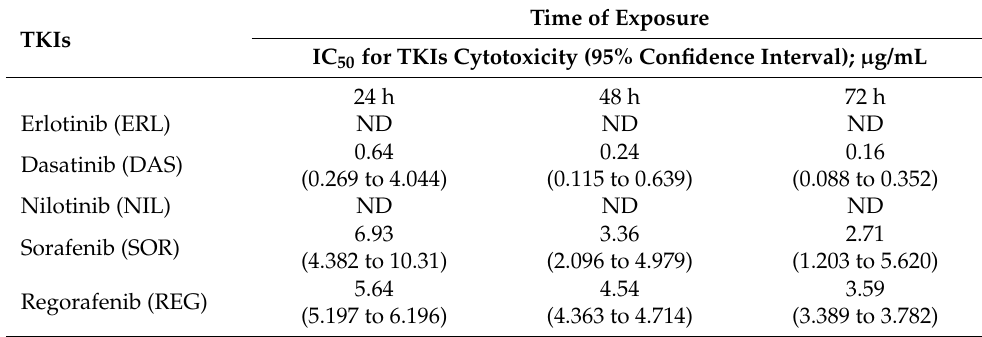
Table 2. IC 50 values of TKIs in zebrafish liver cells (ZFL) after 24, 48, and 72 h of exposure. Time of Exposure TKIs IC 50 for TKIs Cytotoxicity (95% Confidence Interval); µ